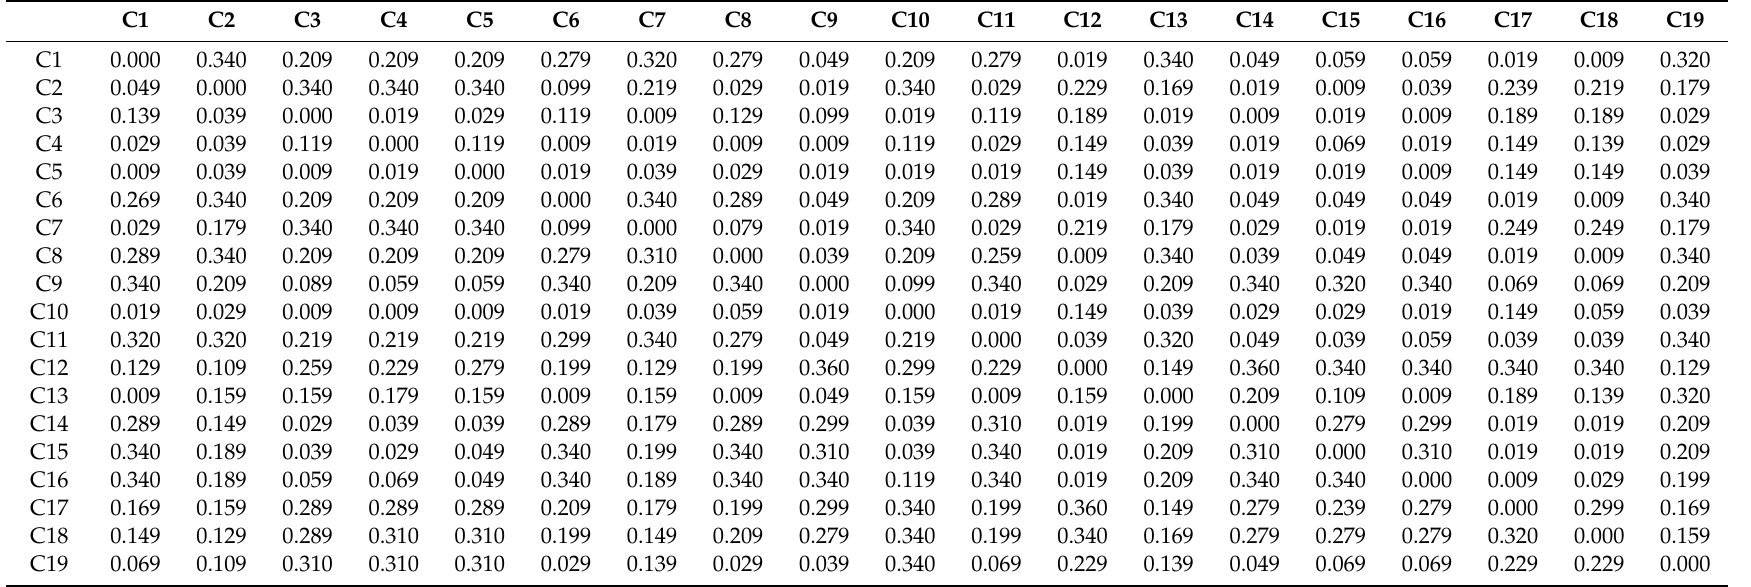
Table 4. Direct Impact